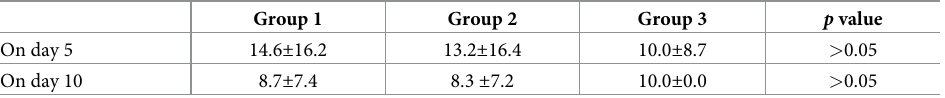
Table 2. Comparison of voiding number per hour among the following groups: Group 1, direct injection of USC to the bladder submucosa; Group 2, transurethral instillation of USC; Group 3, injection of USC via the tail